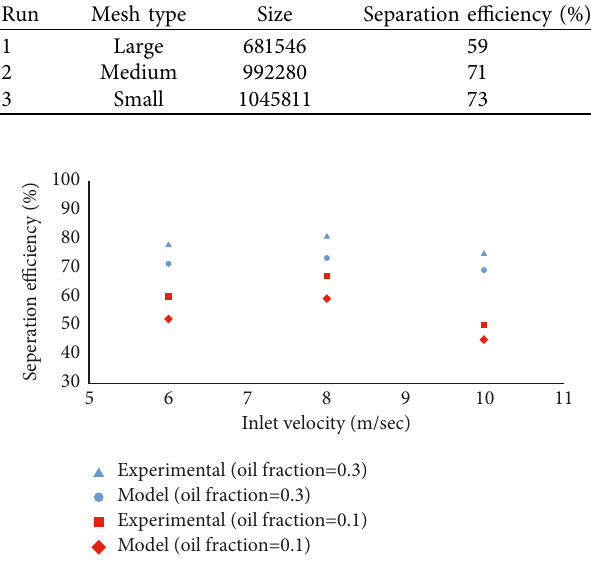
Figure 5: Comparison of simulation results with experimental data